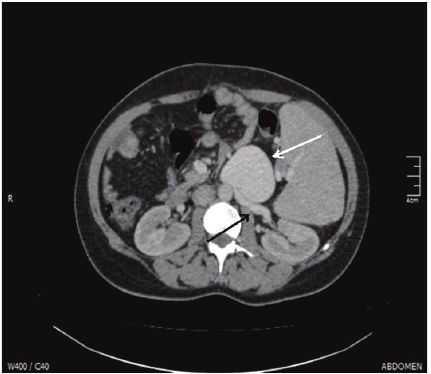
Figure 1: Computed angiography showing a large-sized renal vein aneurysm (white arrow) arising from the left renal vein (black